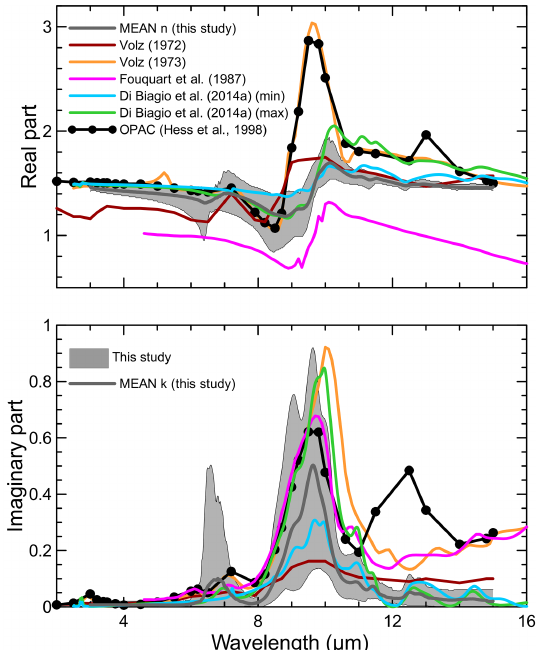
Figure 12. Comparison of results obtained in this study with literature-compiled values of the dust refractive index in the LW. Literature values are taken from Volz (1972) for rainout dust col- lected in Germany, Volz (1973) for dust collected at Barbados, Fouquart (1987) for Niger sand, Di Biagio et al. (2014a) for dust from Niger and Algeria, and the OPAC database (Hess et al., 1998). The region in gray in the plot indicates the full range of variability obtained in this study, and the dashed line is the mean of n and k ob- tained for the different aerosol samples. The legend in the top panel identifies the line styles used in the plot for the literature